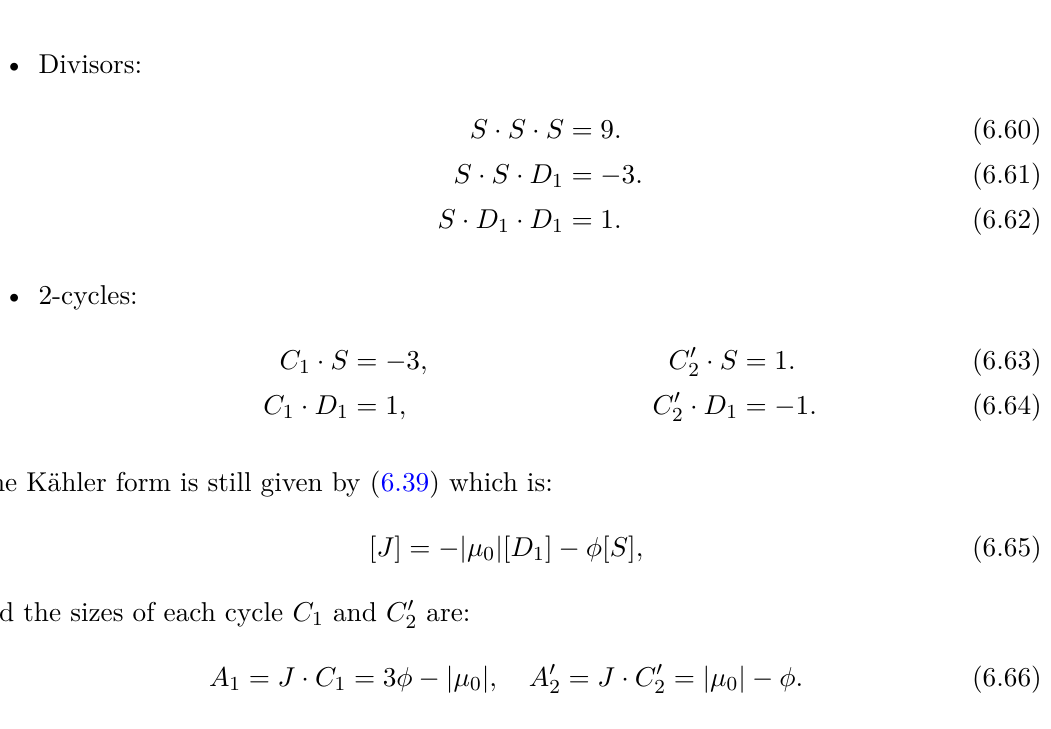
Figure 18 . The flopped toric diagram for F1